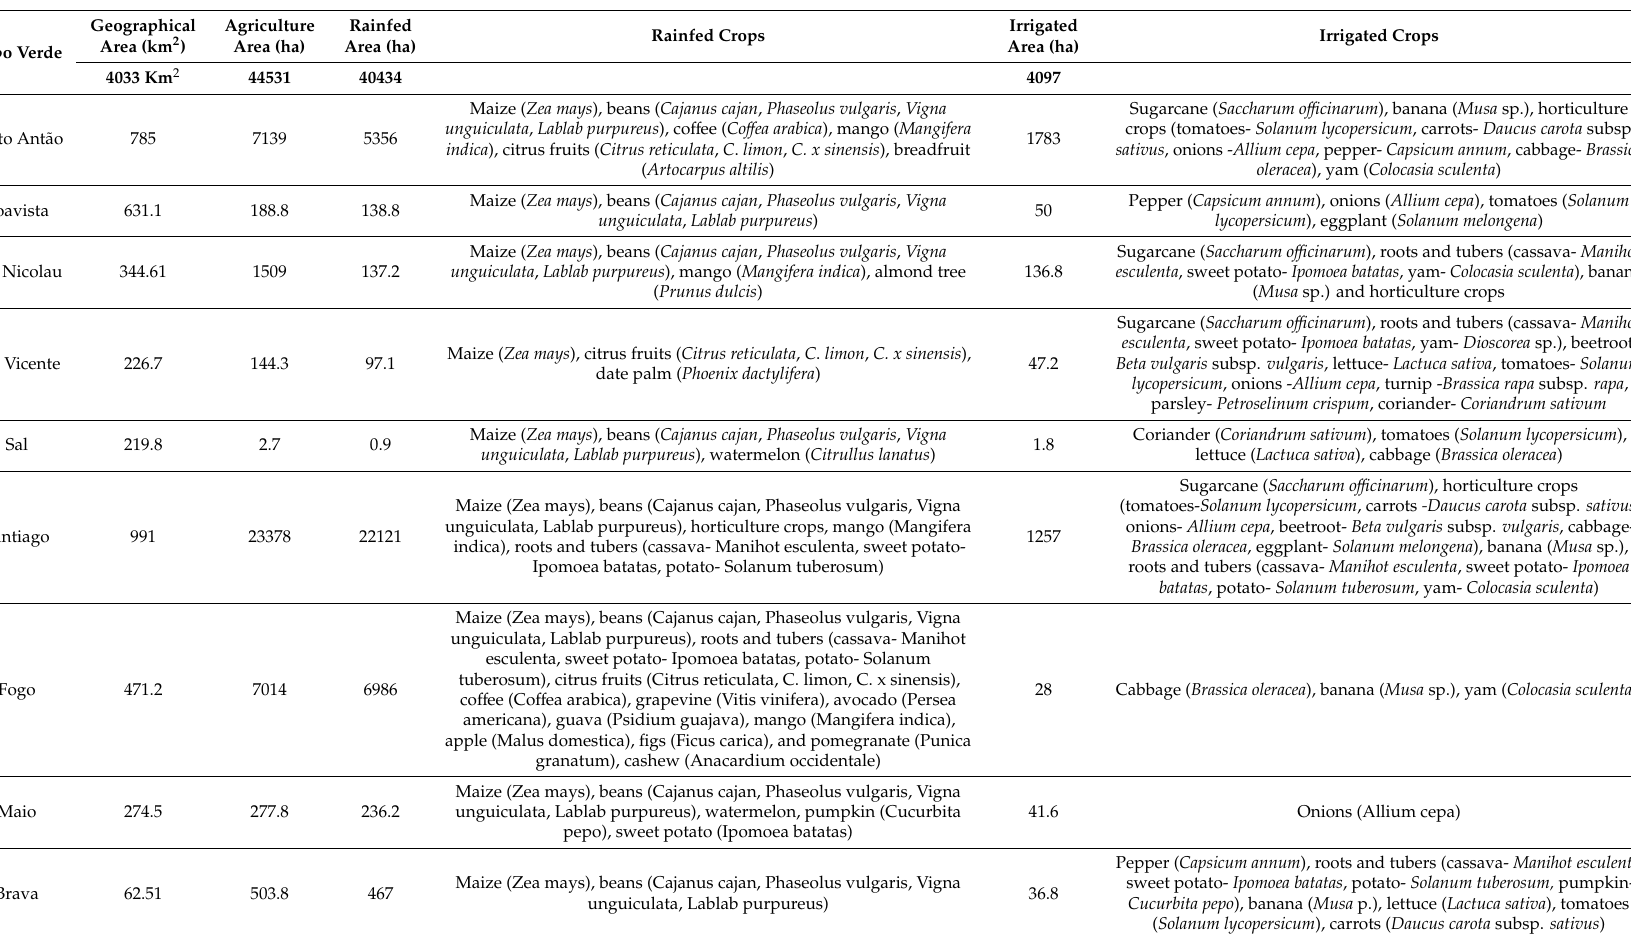
Table 2. Data compiled from Cabo Verde islands concerning agriculture areas (total, rainfed and irrigated) and type of crops under each farming system (rainfed or